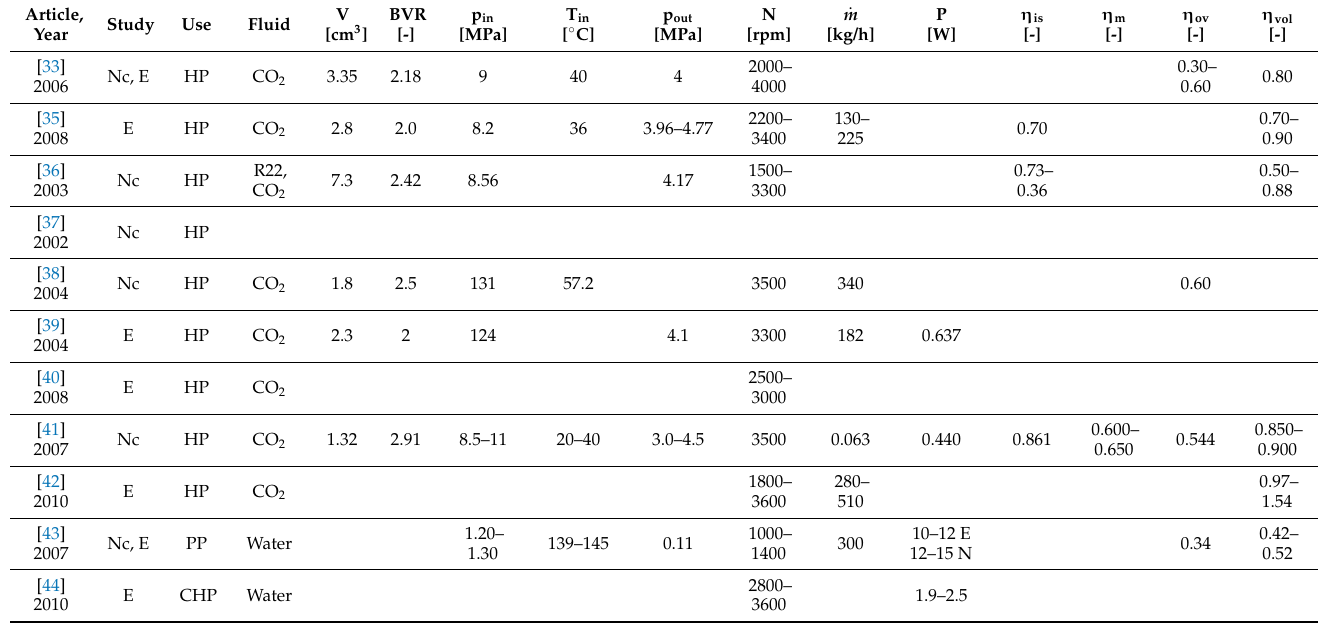
Table 1. Experimental and numerical results related to two-phase scroll